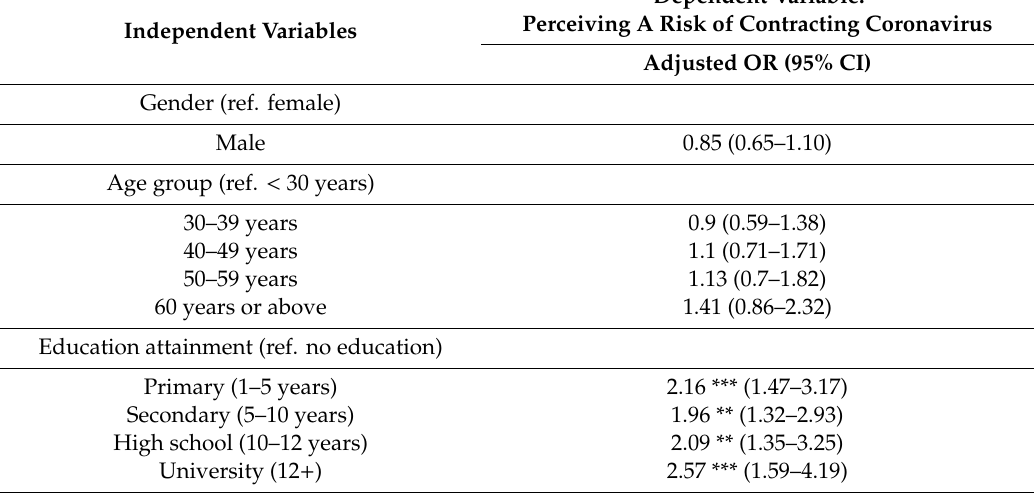
Dependent Variable: